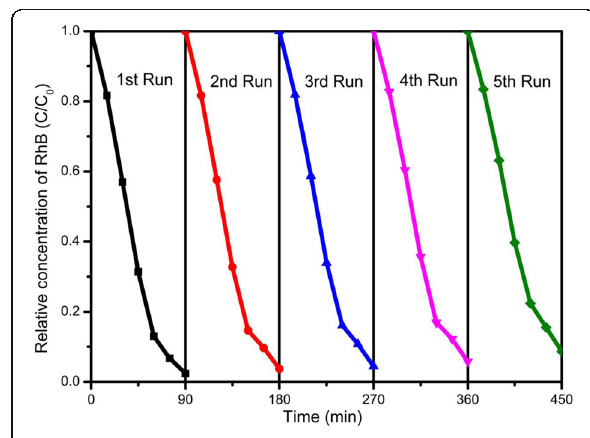
Fig. 10 Recyclability test of NTG5 nanocomposite for consecutive reaction cycles